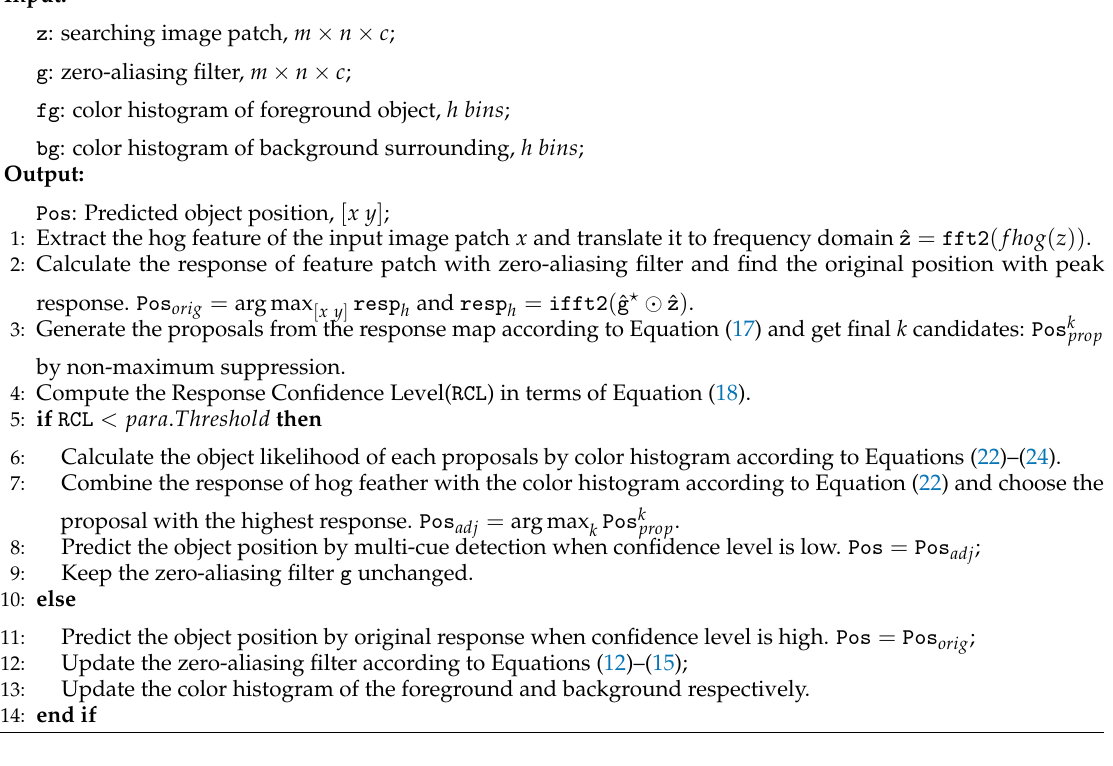
Algorithm 1 Framework of proposed region proposal correlation filter